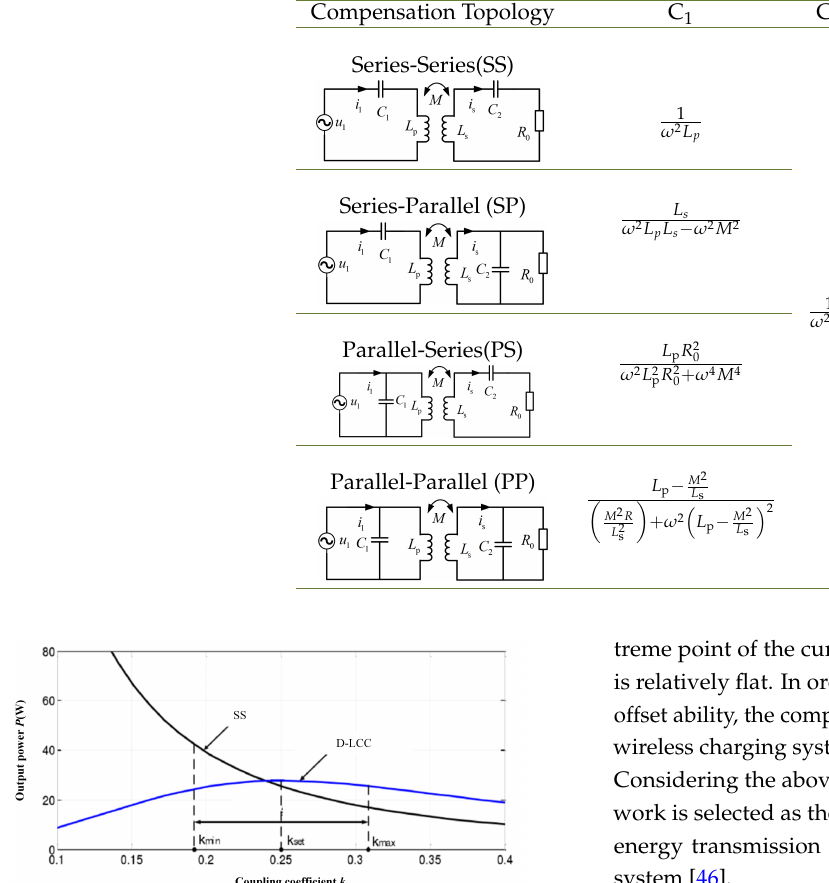
topology are D-LCL and D-LCC. Different compensation networks have different current and voltage attributes, Ta- ble 2 shows the comparison of output current and trans- mission power of SS, D-LCL and D-LCC compensation